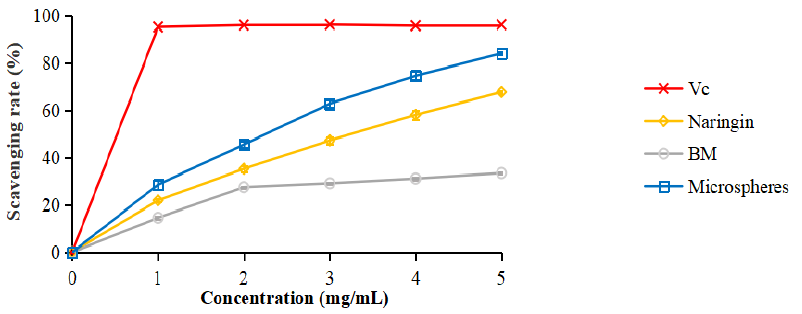
Figure 6. DPPH radical scavenging activity of different concentrations of Vc, naringin, BMs, and microspheres.